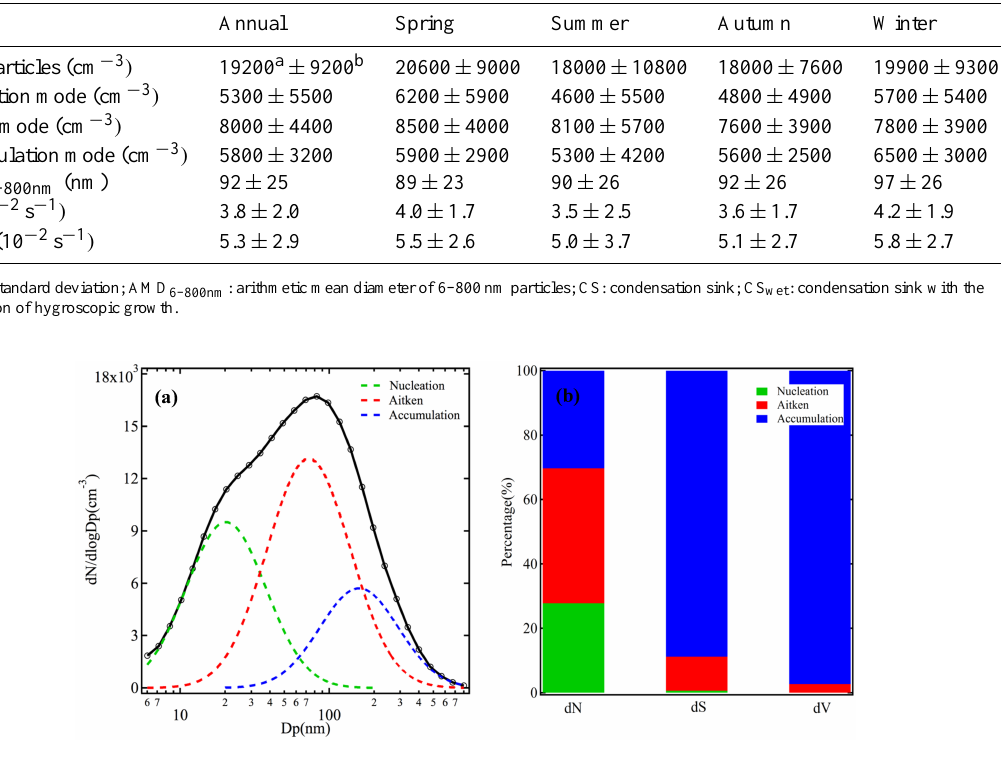
Figure 1. (a) Averaged number size distribution and lognormal fitting curves of three modes, and (b) averaged fraction of the particles number, surface and volume concentrations in the three modes measured at the SORPES site during December 2011–November